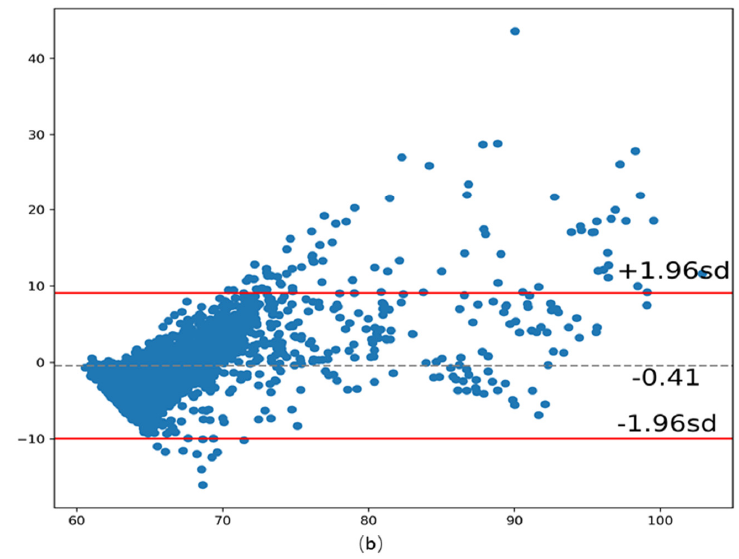
Figure 6. Bland–Altman diagram of true value and estimated value; ( a ) SBP ( b ) DBP.